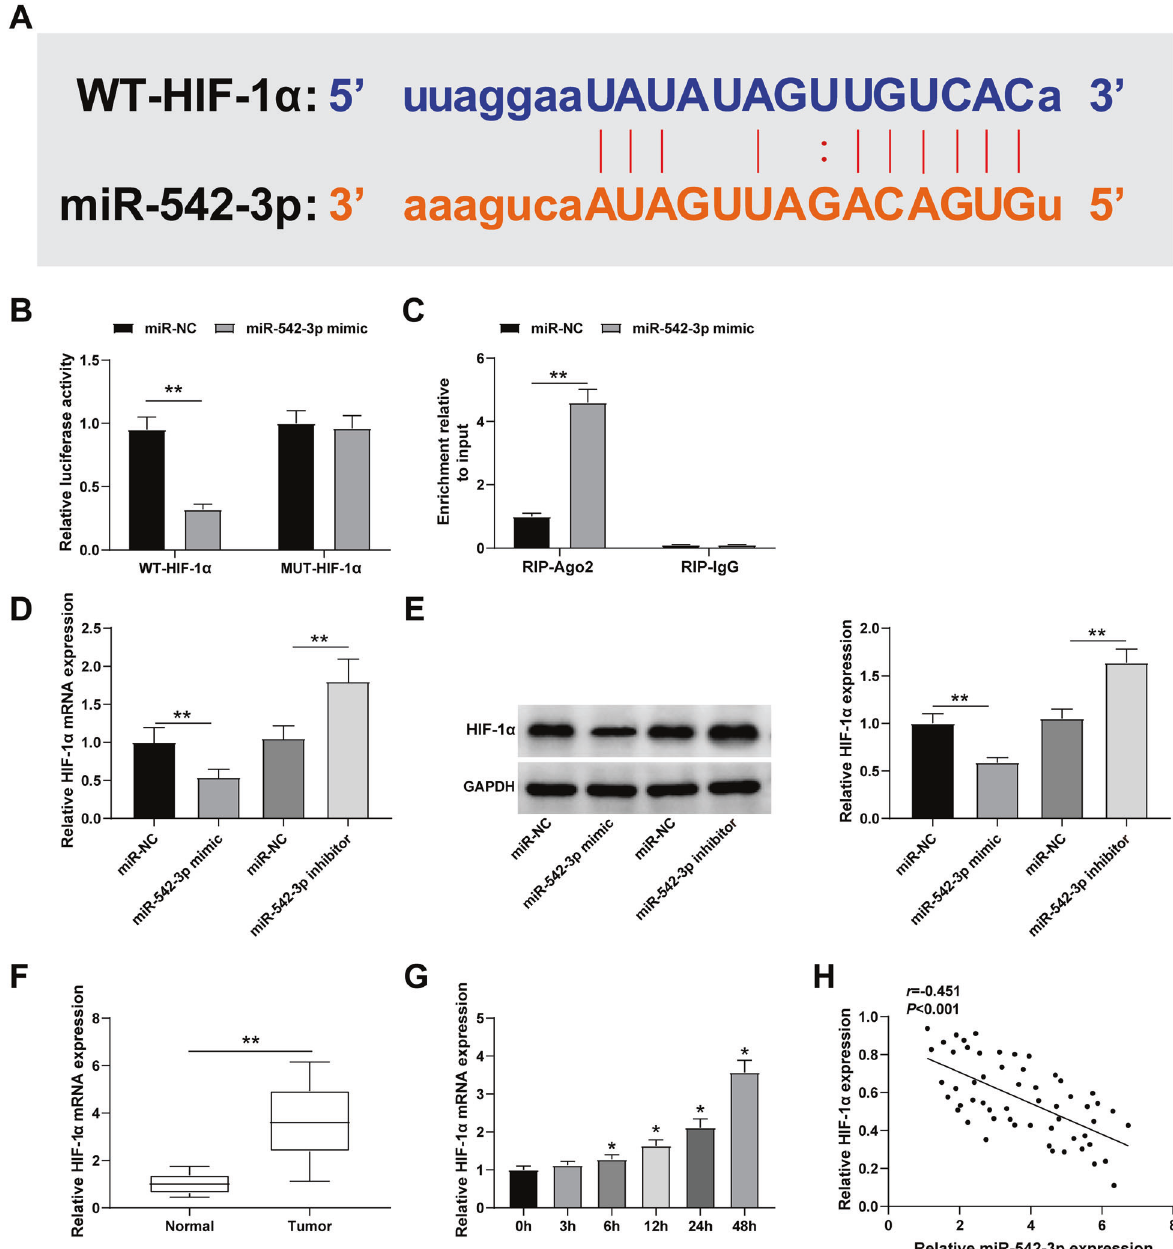
Fig. 6 MiR-542-3p targets HIF-1 α . A The binding site between miR-542-3p and HIF-1 α ; B Dual luciferase reporter experiment con fi rmed the interaction between miR-542-3p and HIF-1 α ; C RIP experiment con fi rmed the interaction between miR-542-3p and HIF-1 α ; D , E HIF-1 α expression after downregulating or upregulating miR-542-3p; F HIF-1 α was upregulated in BCa tissues; G HIF-1 α was upregulated in hypoxia- induced BCa cells; H Pearson test analyzed the correlation between miR-542-3p and HIF-1 α ; ** P < 0.01; * P < 0.05. Data were expressed in the form of mean ± standard deviation (Repetitions = 3). The comparison between two groups should be performed by t test, that among multiple groups was by one-way ANOVA, while pairwise comparison was by Tukey ’ s method. The correlation was analyzed using Pearson correlation